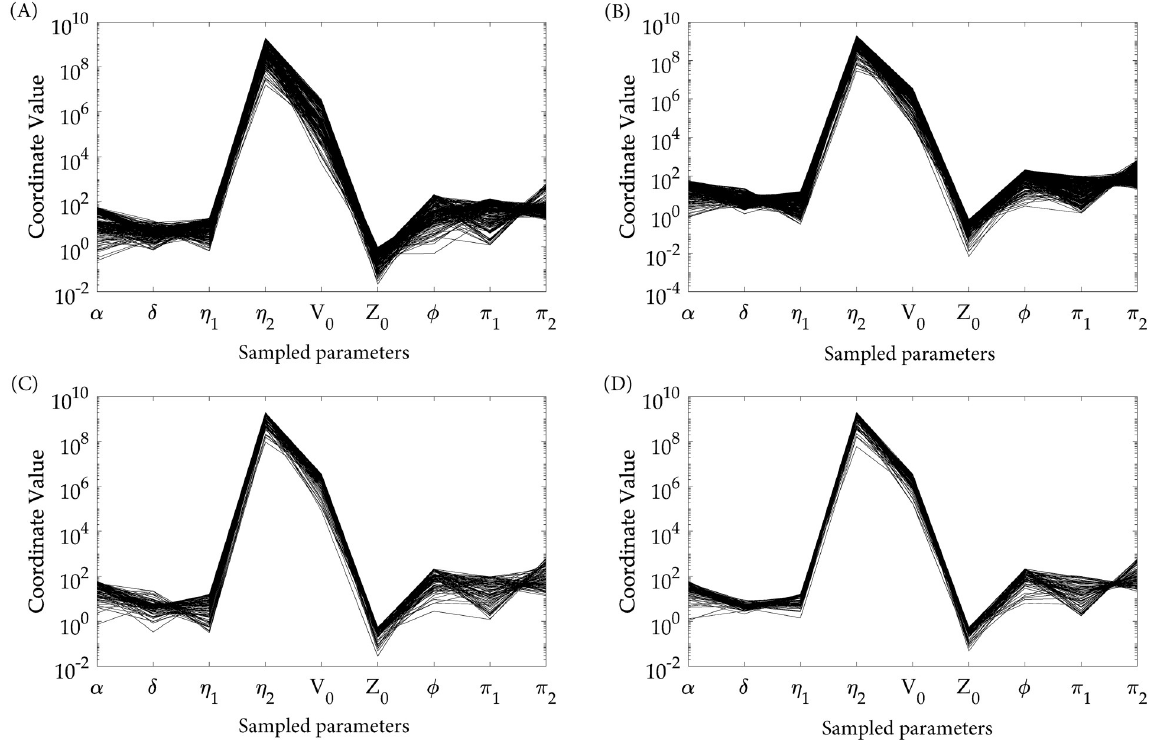
Fig 4. Variability in model parameters. The patient-specific parameters are shown in parallel co-ordinates for the four calibrated POMs of (A) DENV-1, (B) DENV-2, (C) DENV-3 and (D) DENV-4. These parameters values represent the models included in the four serotype-specific POMs. The parameters have been sampled for 20,000 models using Latin Hypercube Sampling from a domain of 10 − 2 to 10 2 times the initial parameter values and parameter sets for the qualified models included in the parallel co-ordinates. If we draw multiple copies of the y-axis, perpendicular to the x-axis and equidistant with each other, then these represent the axes of the multi-dimensional parallel coordinates for a high dimensional Euclidean system [44, 45]. Any data point in a multi-dimensional space can be mapped on a polyline that connects each axis of the parallel coordinates at a distance proportional to its coordinate